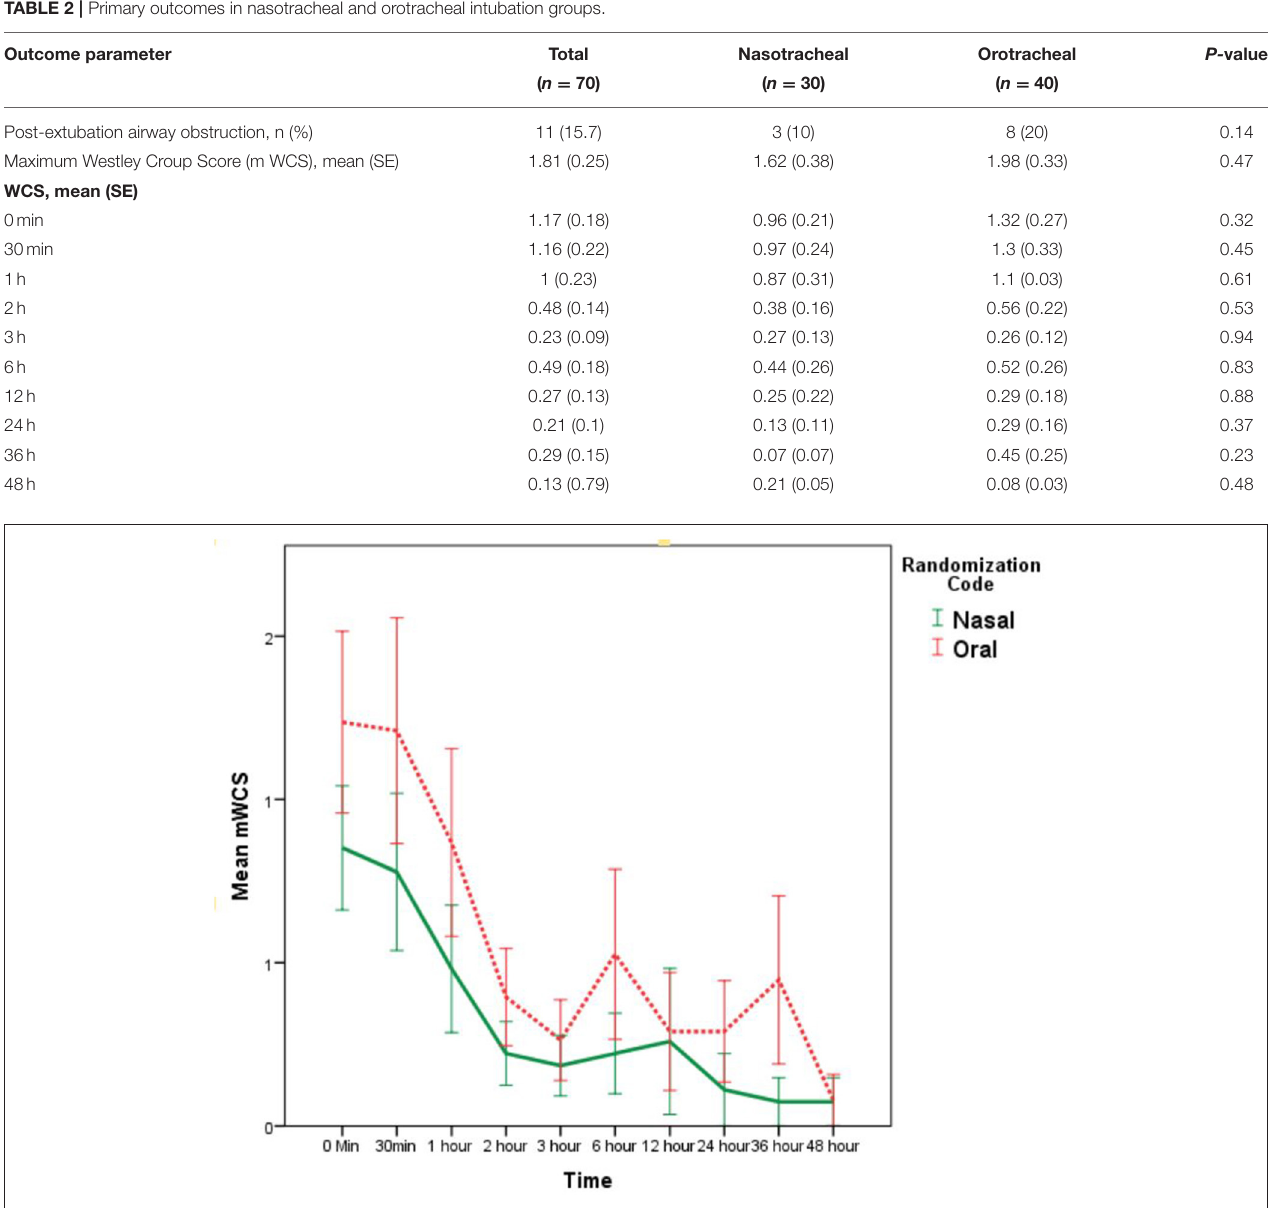
FIGURE 2 | mWCS [mean (SE)] in nasotracheal and orotracheal intubation groups at different time points after